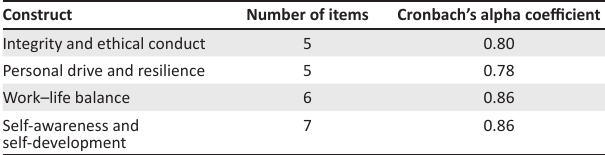
TABLE 1: Cronbach’s alpha values for the measurement